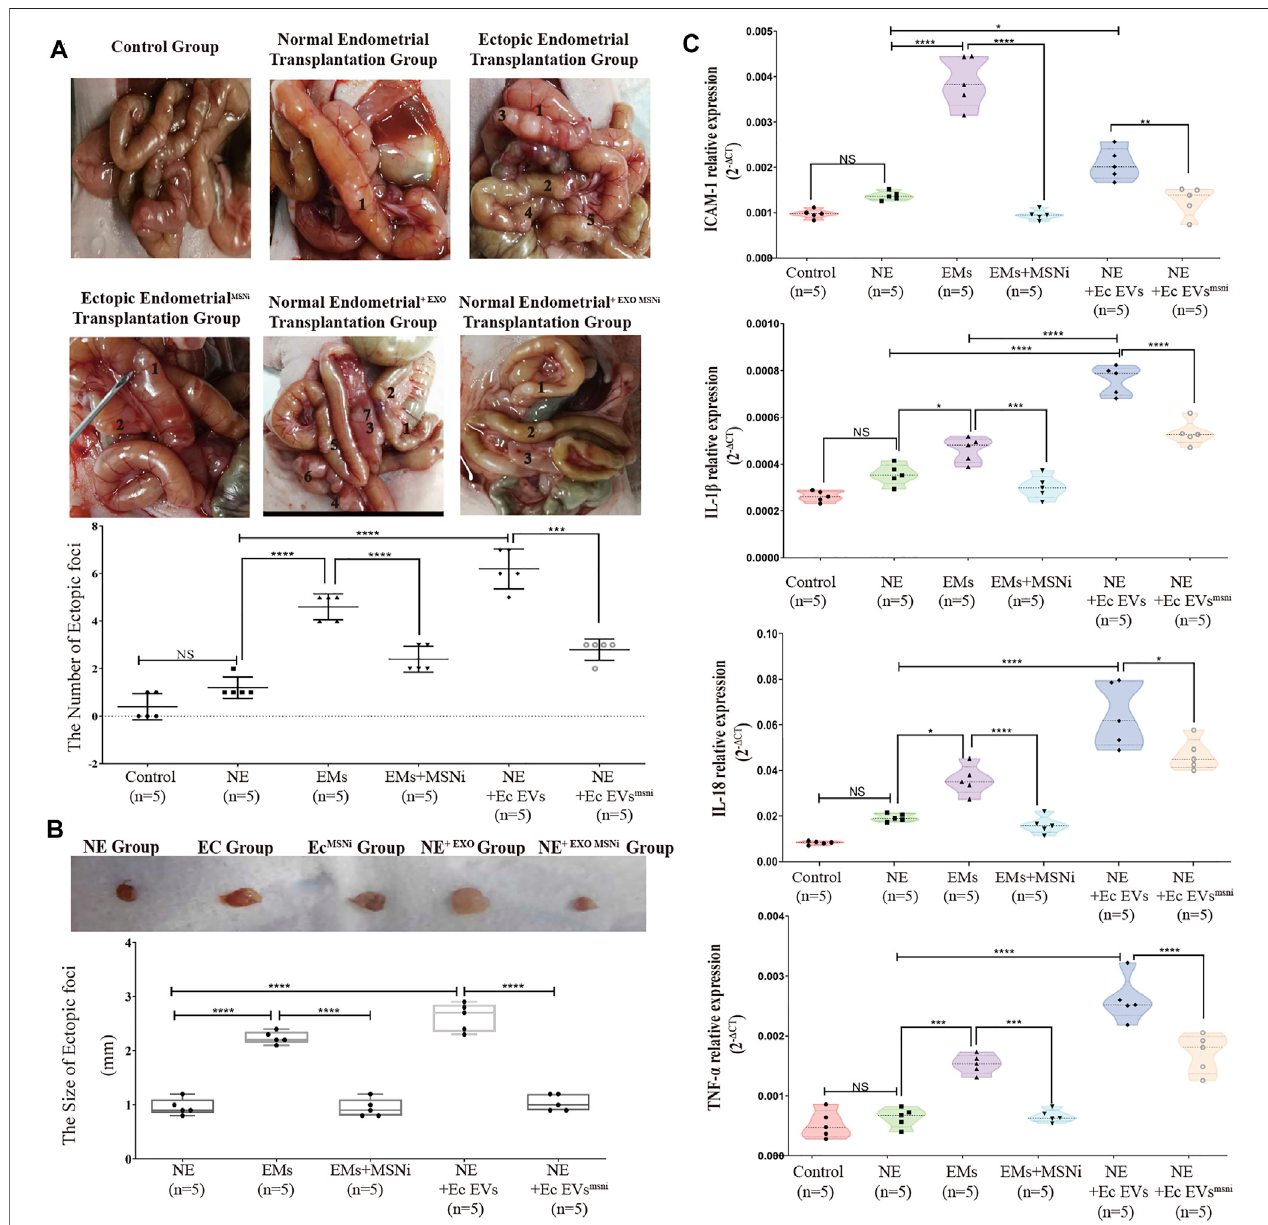
FIGURE 5 | (A) The model of heterotopia mouse was established by intraperitoneal injection. Ectopic stromal cells and normal endometrial stromal cells + ectopic exosomes notably increased the number of ectopic foci compared with the normal endometrial stromal cells group and control group ( p < 0.0001), while MSNi and exosomal MSNi inhibited this phenomenon ( p < 0.0005). (B) The size of ectopic implant tissue. Ectopic exosomes could increase the size of ectopic tissue the same as theectopiccells,butexosomalMSNiandectopiccells+MSNidecreasedthesize( p < 0.0001). (C) Theexpressionofin fl ammatorycytokines:IL-1 β ,ICAM-1,IL-18, and TNF- α in the small intestinal tissue surrounding the heterotopic foci. Data were expressed as mean ± SEM, NS, no signi fi cance, **** p < 0.0001.